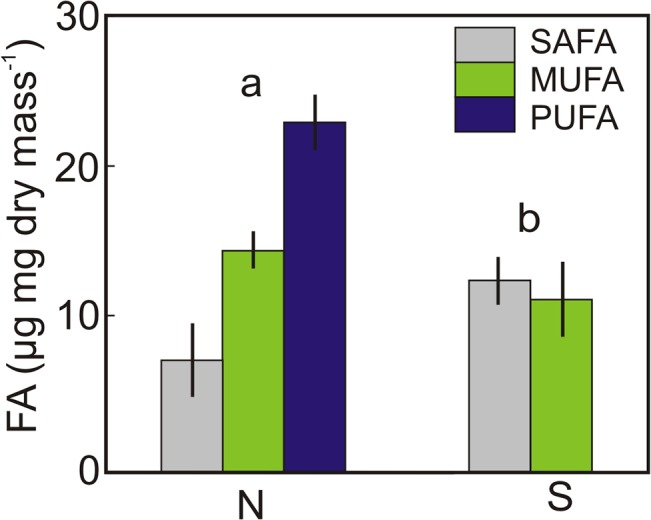
The FA content and composition of two picophytoplankton food types used in the growth experiments.The concentrations of saturated (SAFA), monounsaturated (MUFA) and polyunsaturated (PUFA) fatty acids (±SE, n = 5) in Nannochloropsis (N) and Synechococcus (S). The different letters indicate a significant difference in total fatty acid content at p<0.001.